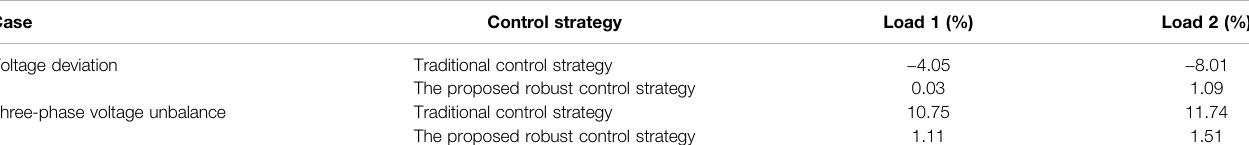
TABLE 3 | Electricity quality analysis.